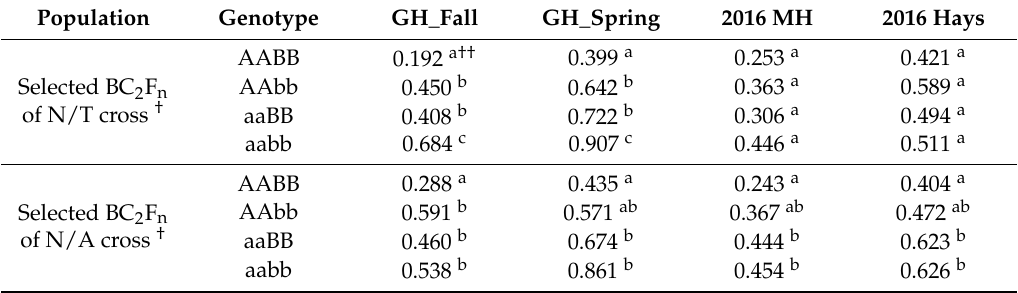
Table 3. Combined genetic effects of TaPHS1 and TaMKK3-A genes from Tutoumai A and AUS1408 in both greenhouse and field experiments in Manhattan (MH) and Hays,